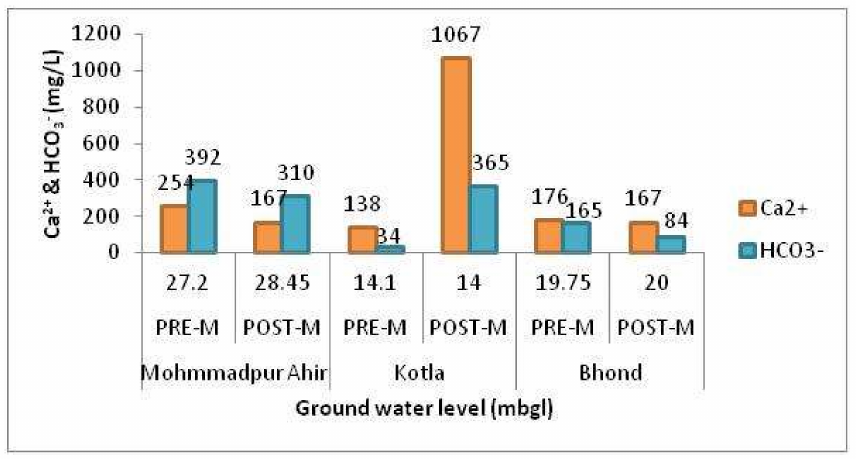
Figure 7. Seasonal change in Ca 2+ and HCO 3 − ions with groundwater-level